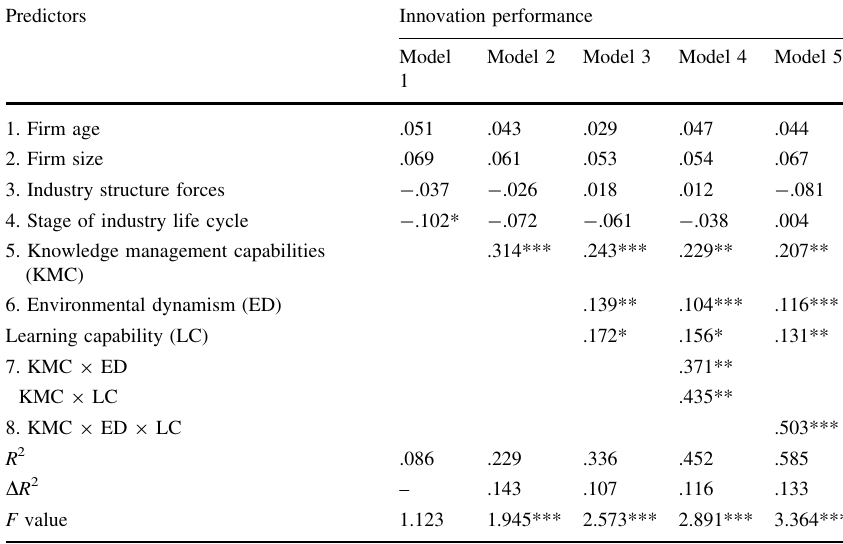
Table 4 The results of regression